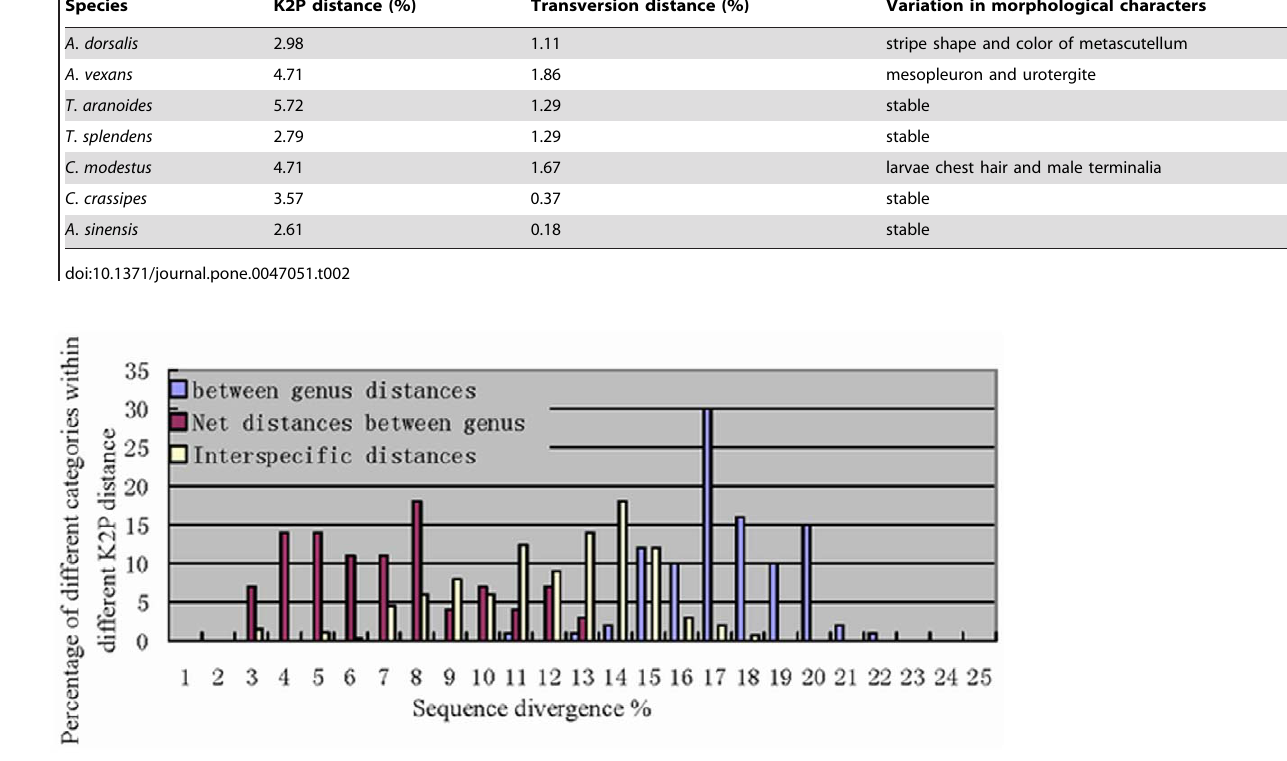
Figure 4. Pairwise comparisons between COI sequences among mosquito species separated into three categories; interspecific distances, between gene distances and net distances between genera. All sequences were grouped with MEGA software, each group includes all species of a particular genus.